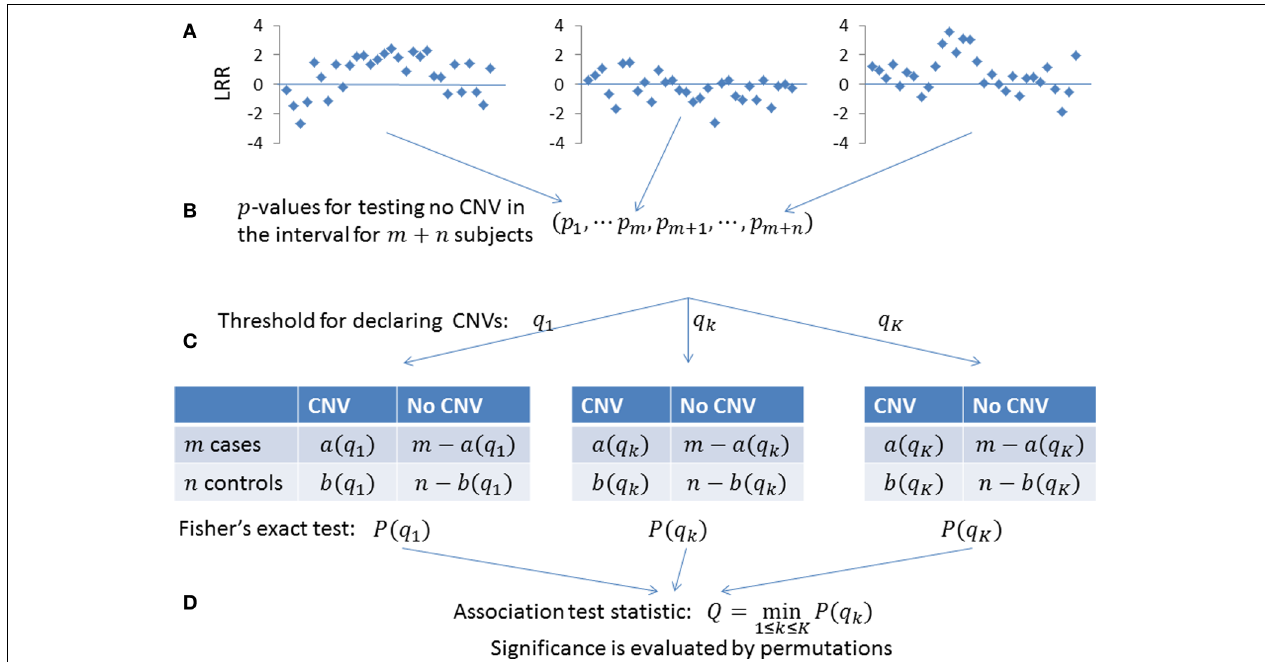
FIGURE 2 | Testing the association of CNVs in a given genomic region. (A) LRRs in the given genomic region for m + n subjects. (B) The existence of a CNV anywhere in the region is quantified as a p -value. A small p -value indicates the presence of a CNV. (C) For a given threshold q 1 , subjects with p -value < q 1 are determined as tentative CNV carriers. We have a(q 1 ) CNV